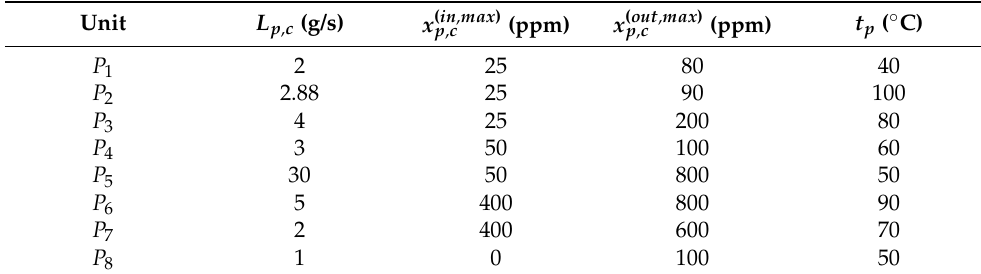
Table 7. Process water-using units data for Example 4.